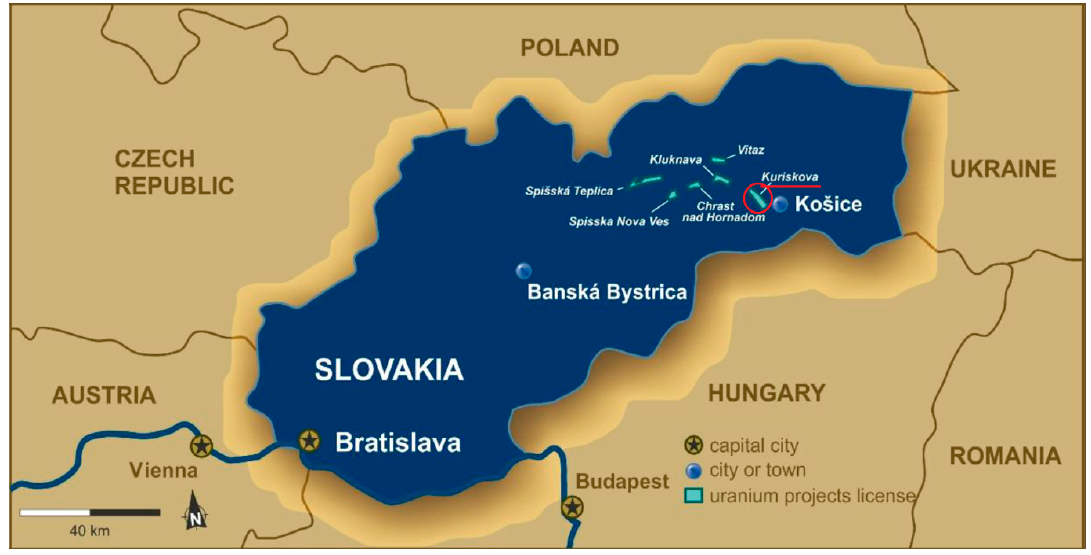
Figure 1. The location of the deposit of Kuriskova [58].